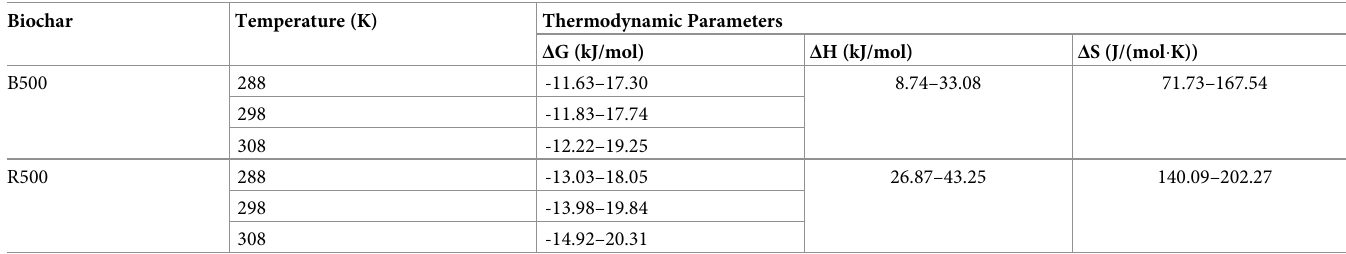
Table 5. Thermodynamic parameters for the adsorption of BR46 onto biochar.